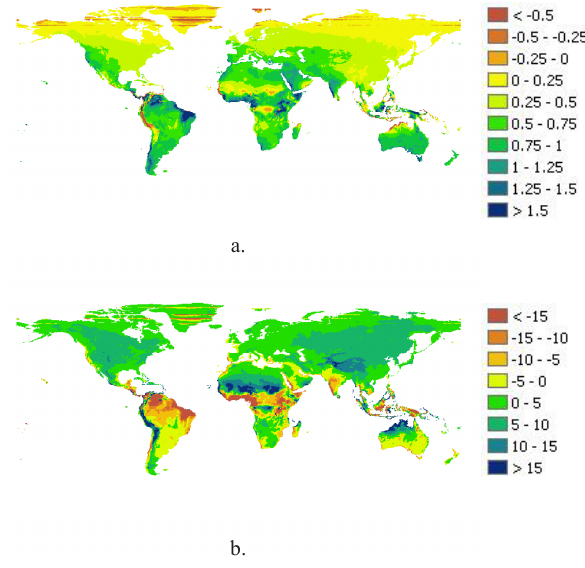
Fig. 1. Cell specific values of the coefficients in the re-calibrated Blaney-Criddle equation. The values in (a) replace the number 0.46 and the values in (b) replace the number 8 in the original Blaney- Criddle equation (ET 0 = p (0.46 T